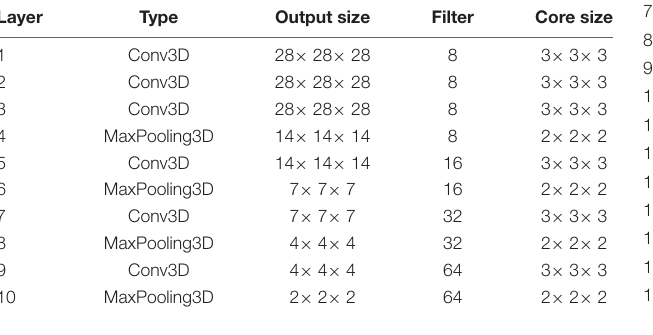
TABLE 1 | Structure of single-frame 3D convolutional neural network (CNN) model.